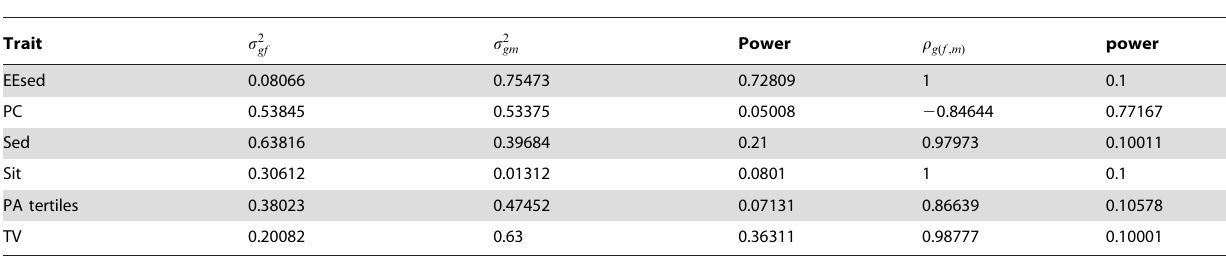
Table 5. Power to detect GxSex interaction